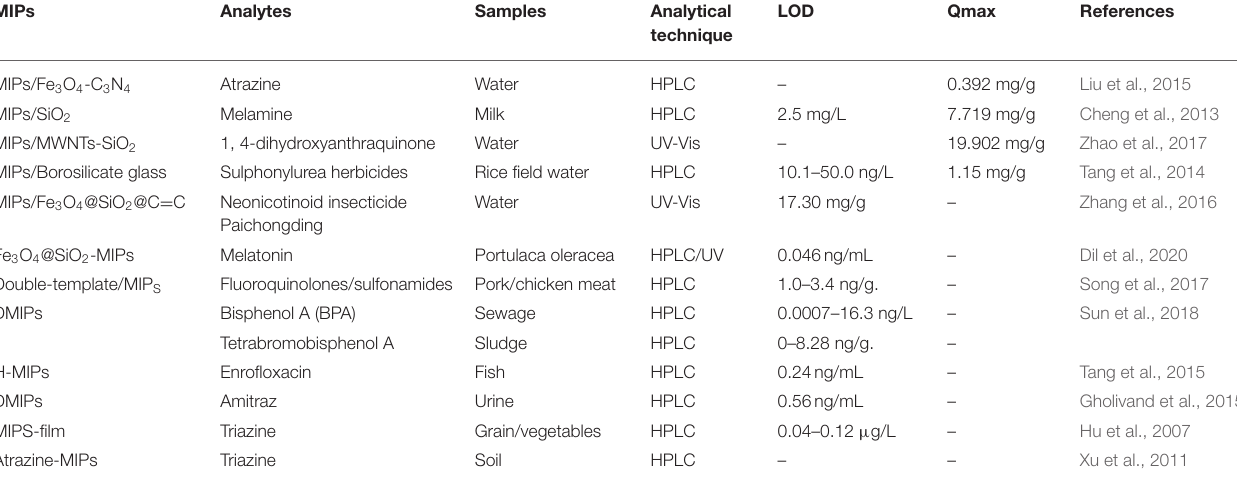
TABLE 1 | Comparison of different detection methods for chemical pollutants based on sample